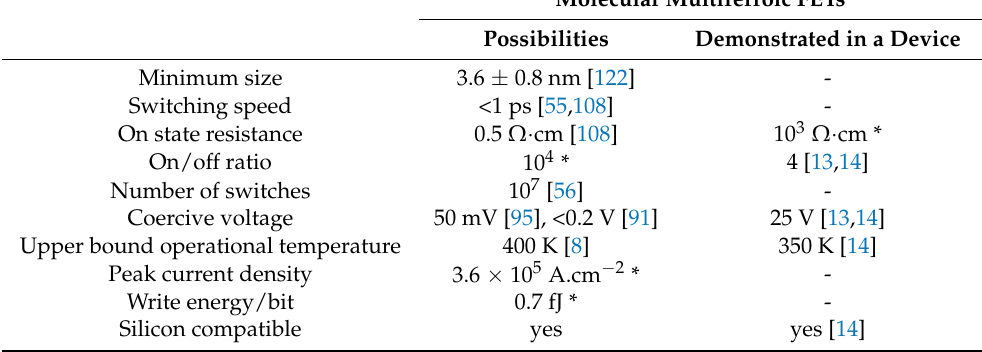
Table 1. Spin crossover molecular multiferroic field effect transistor characteristics as demonstrated in a nonvolatile voltage-controlled device (experiment) and what might be possible from other experiments on spin crossover